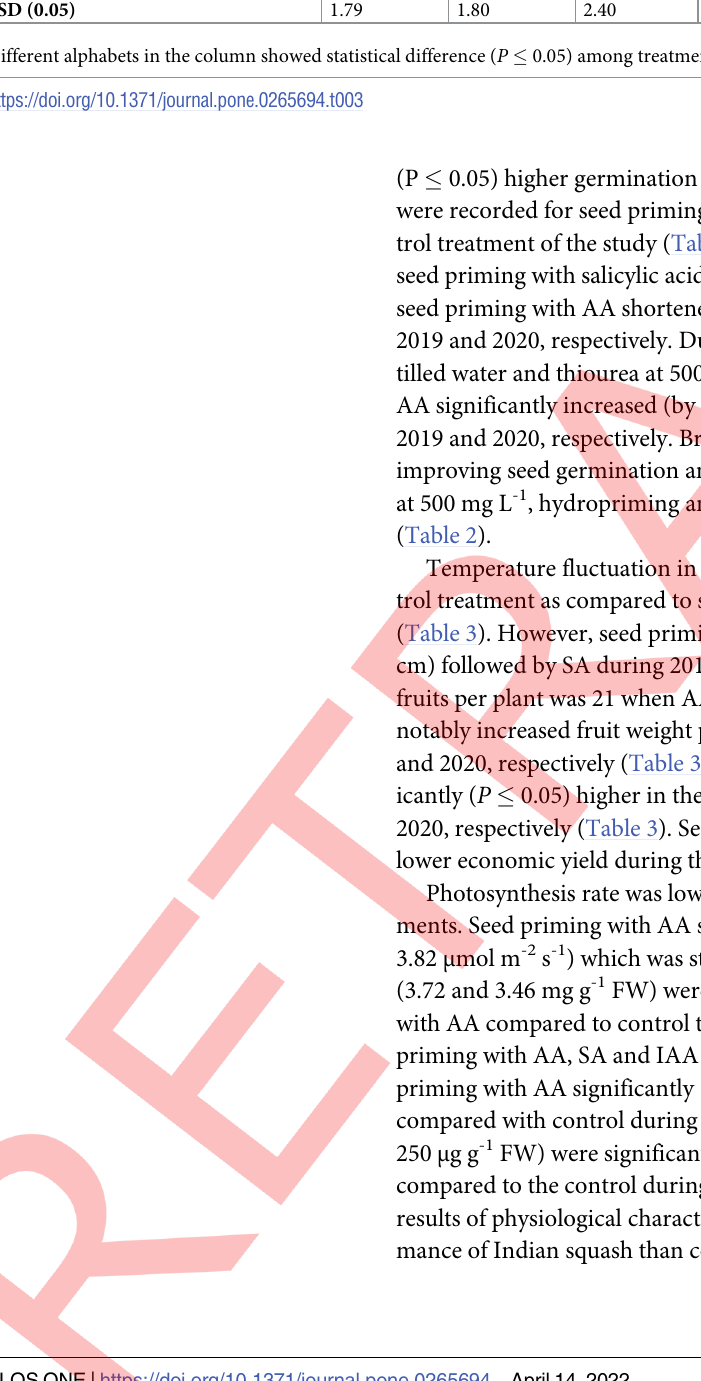
Indole acetic acid at 100 mg L -1